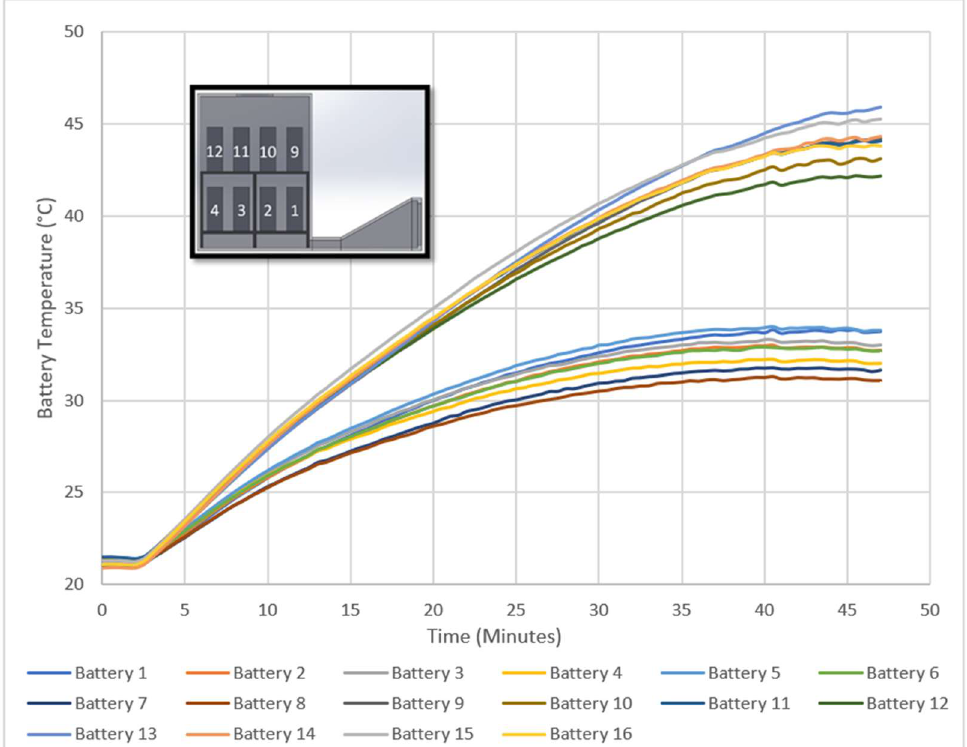
Figure 11. Vent model battery temperatures. The two large groupings reflect batteries placed on either level of the rack. The lower temperatures belong to batteries on the bottom level of the rack and the elevated temperatures belong to batteries on the top level.